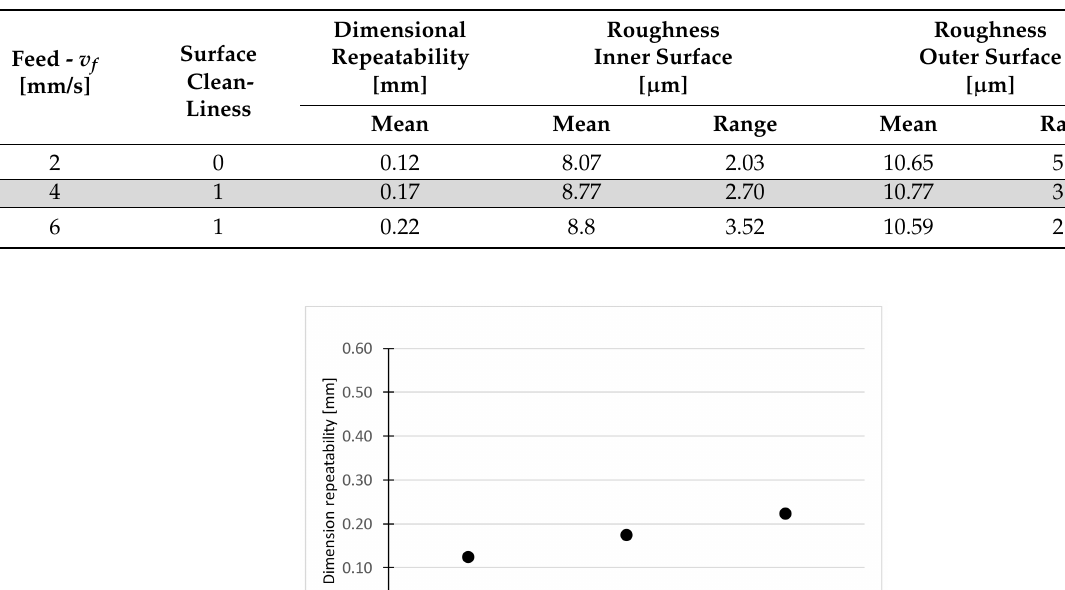
Table 5. Grinding quality depending on the feed of the workpiece ( F n = 10 N, v s = 26 m/s).